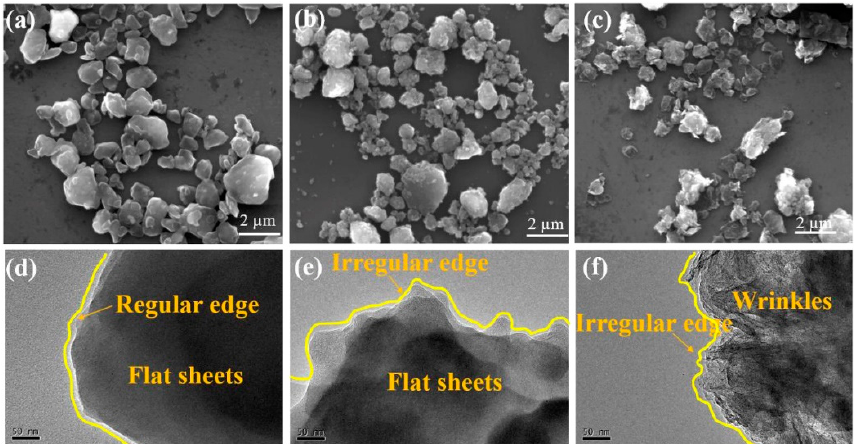
Figure 6. ( a – c ) SEM; ( d – f ) TEM micromorphological images of the three types of graphene sheets: ( a , d ) for RG; ( b , e ) for ir-RG; ( c , f ) for ir-RWG. Reprinted with permission from [66]. © 2017 Elsevier Ltd. All rights